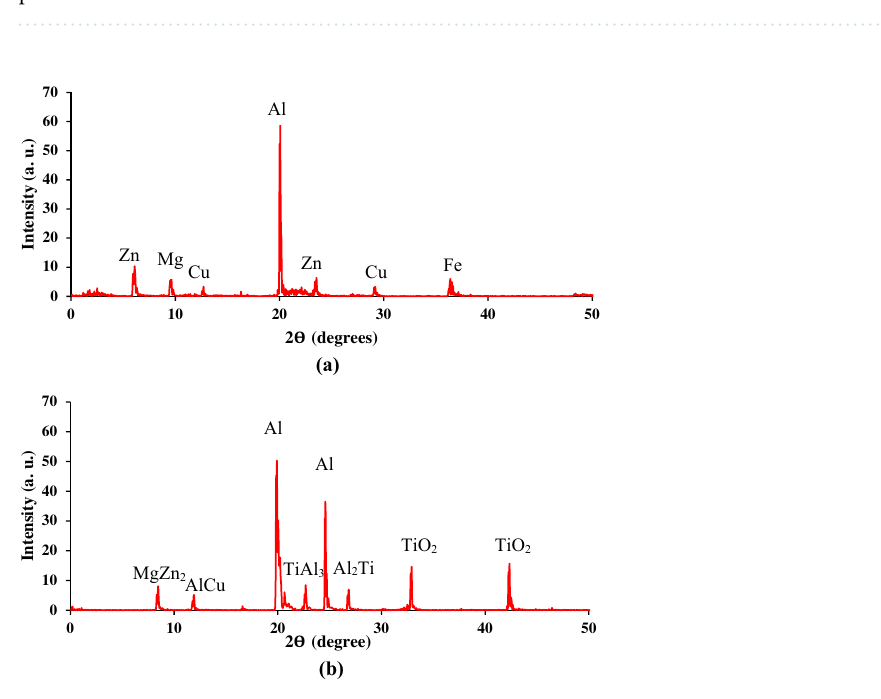
Figure 9. Microstructural image of ( a ) pure al 7075 and ( b ) developed composite at optimal stirring parameters.